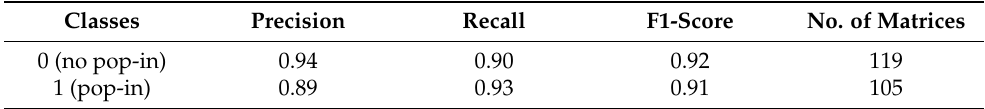
Table 2. Summary of the performance of the CNN model in the validation dataset only using the loading curves.